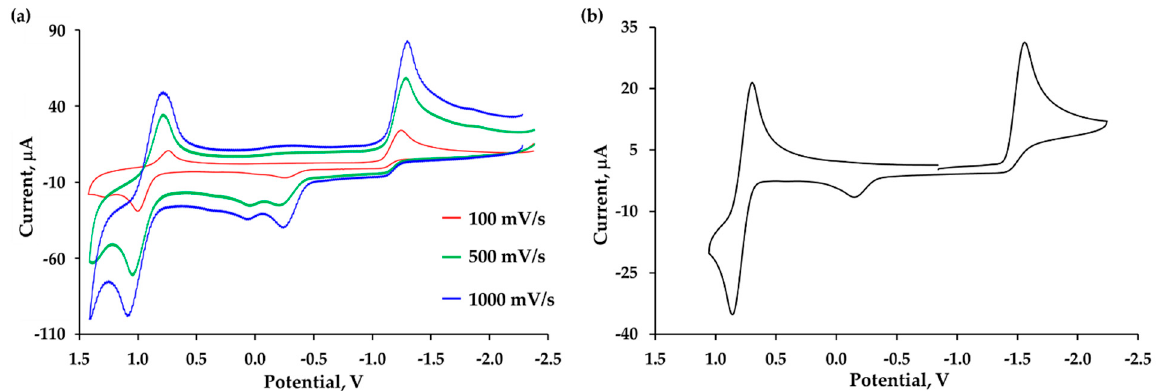
Figure 11. ( a ) Variable scan rate (100, 500, and 1000 mV/s) cyclic voltammograms for ca. 0.02 M solution of 10 in CH 2 Cl 2 with 0.1 M [ n BuN][PF 6 ]; ( b ) cyclic voltammogram of ca. 0.02 M solution of 8 in CH 2 Cl 2 with 0.1 M [ n BuN][PF 6 ]. Scan rate = 100 mV/s.